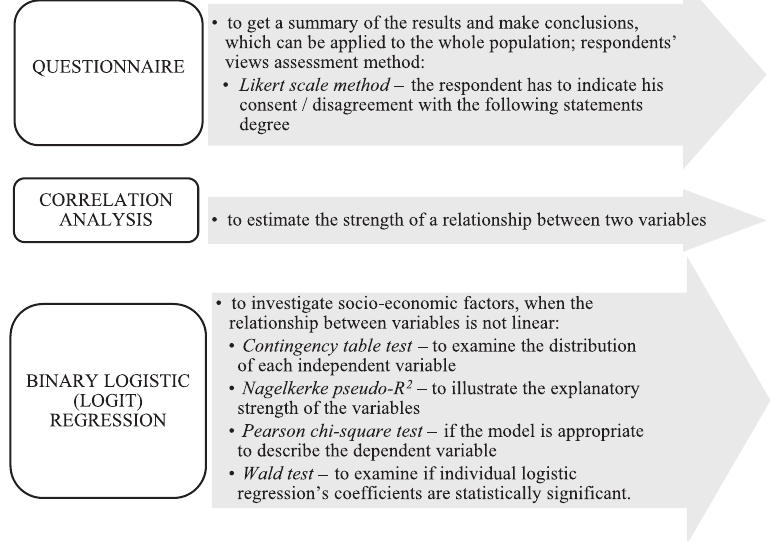
Fig. 1. Model used for the assessment of customers trust in traditional banking Source : created by